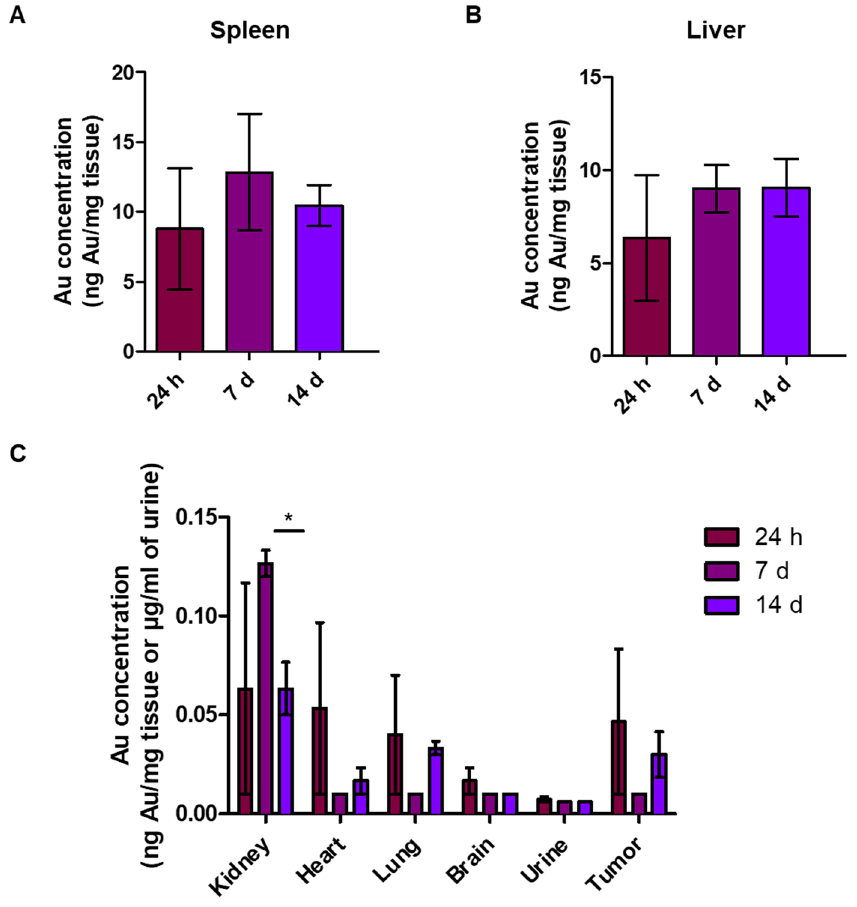
Figure 4. Gold concentration measured by ICP-MS 24 h, 7 days and 14 days after a single injection of AuNPd (1 mg/kg). (n = 3, data are mean ± SEM).